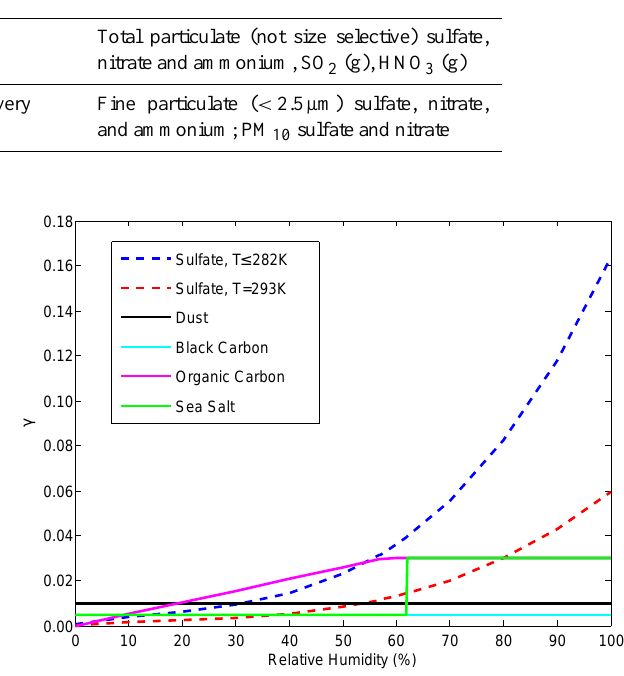
Fig. 2. Values of the N 2 O 5 hydrolysis uptake coefficient γ in GEOS-Chem (Evans and Jacob,